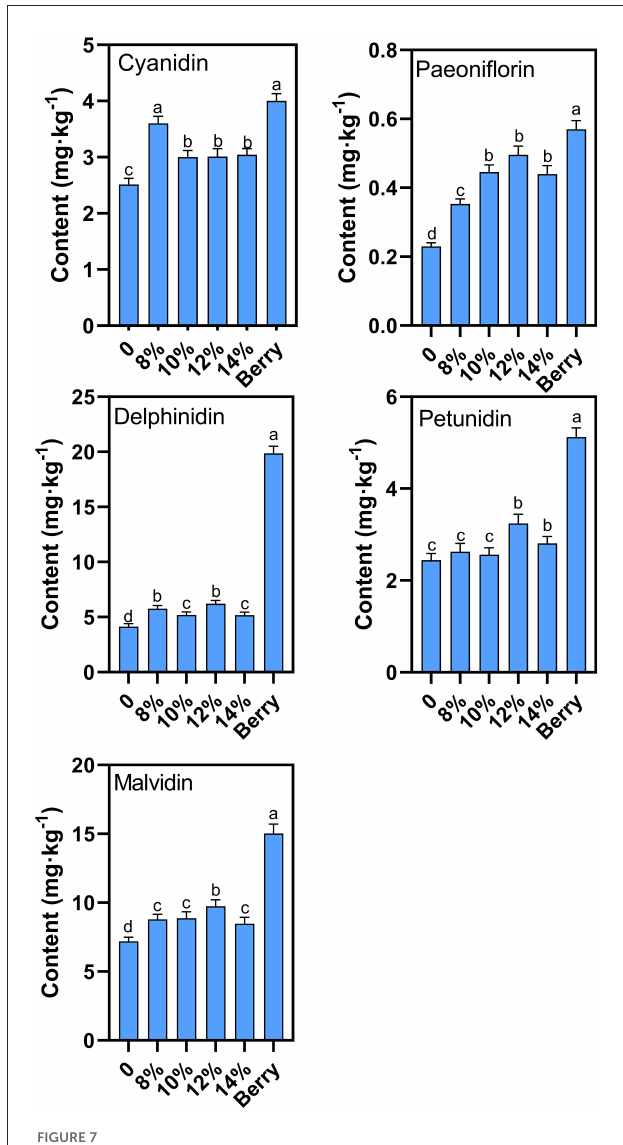
FIGURE7 Effect of additional sucrose on anthocyanins after main fermentation. Different superscript letters in the graph are significantly different ( P <